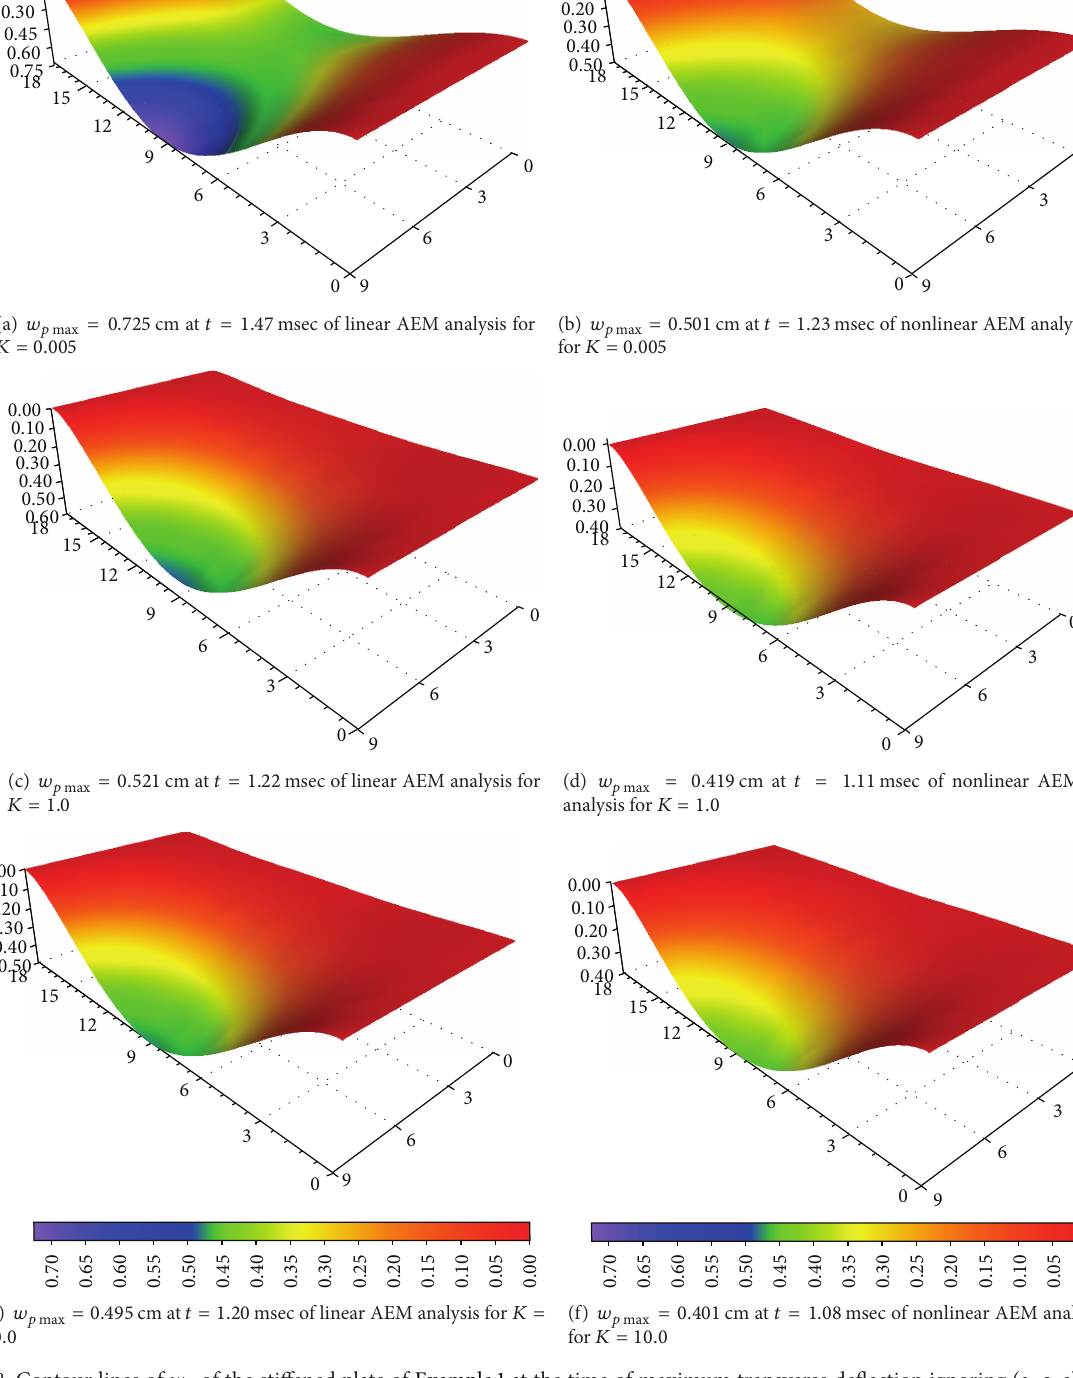
Figure 8: Contour lines of 𝑤 𝑝 of the stiffened plate of Example 1 at the time of maximum transverse deflection ignoring (a, c, e) or taking into account geometrical nonlinearities (b, d,